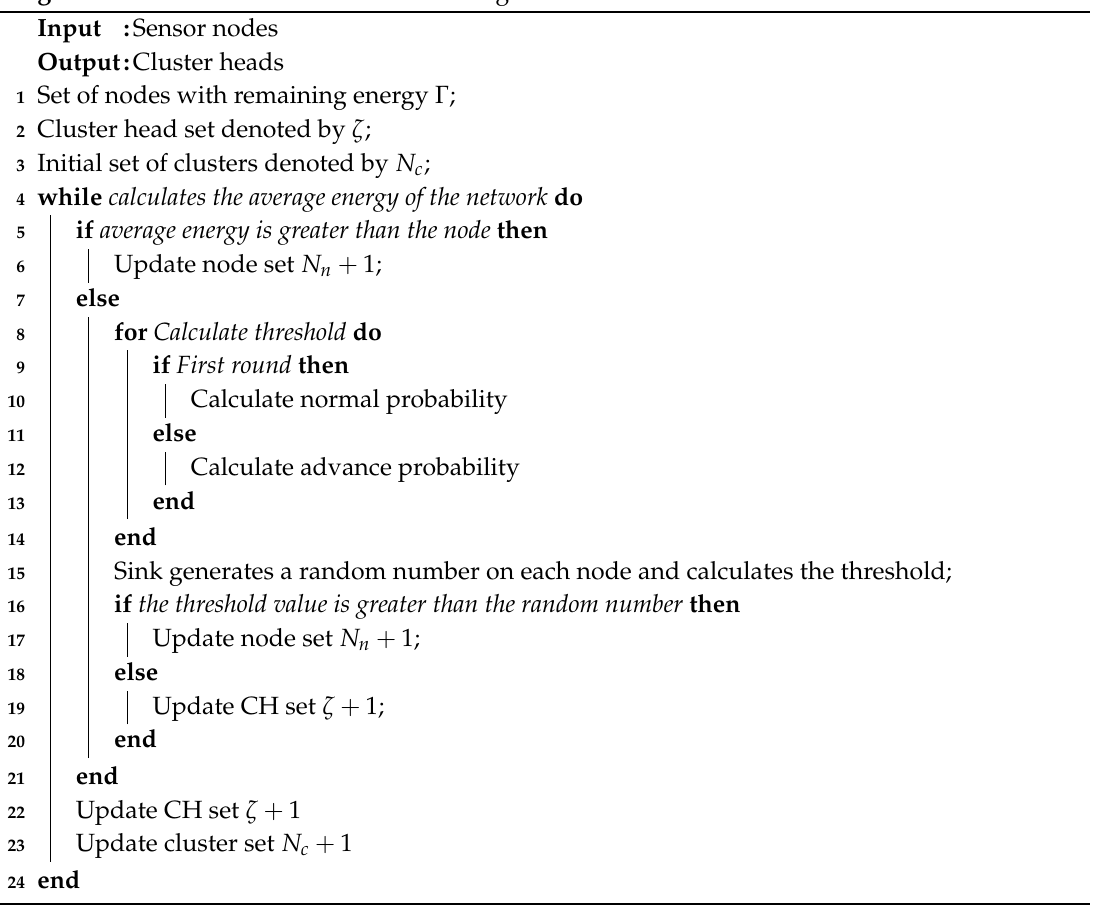
Algorithm 1: Advanced cluster formation